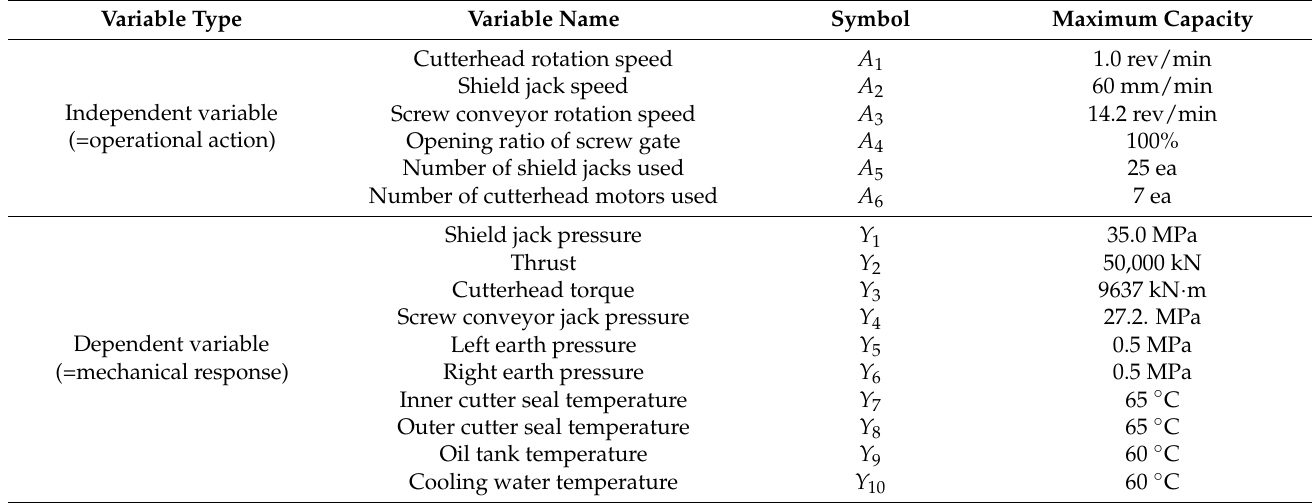
Table 3. Descriptions of operational actions and mechanical responses used for multiple regression analysis.